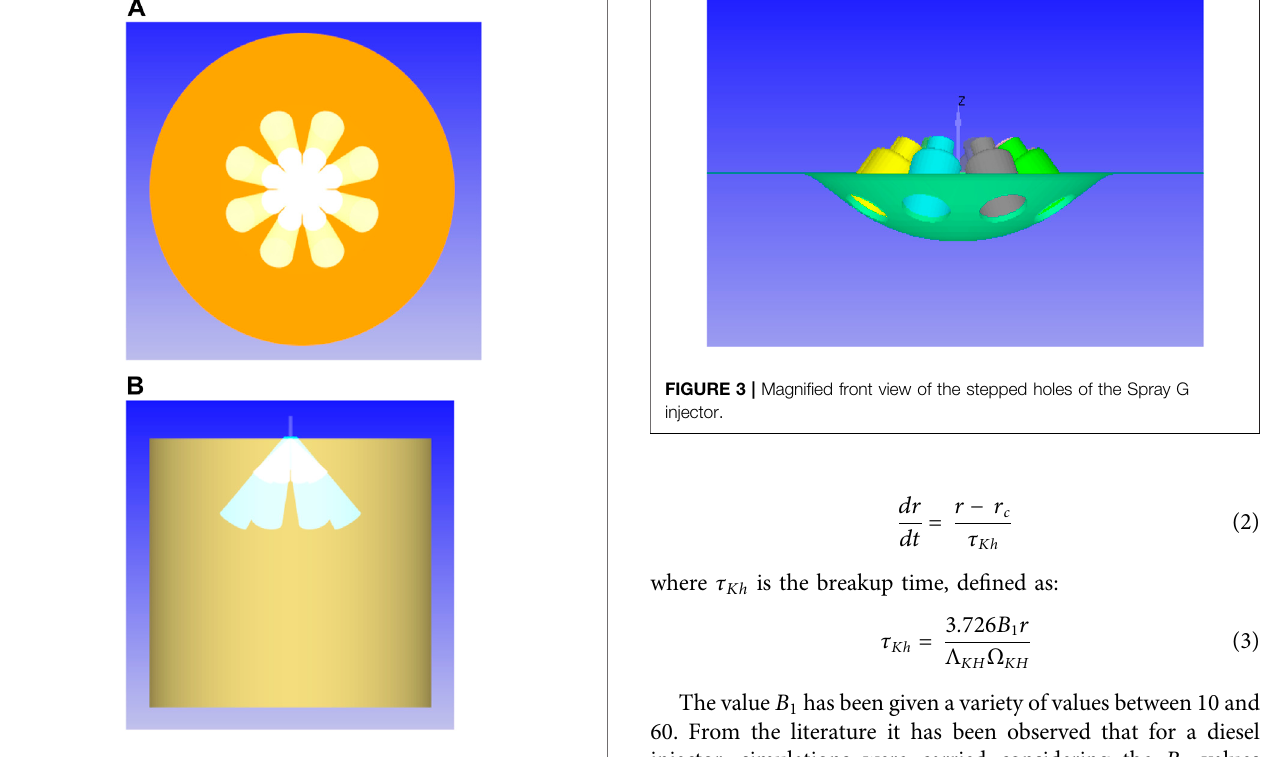
FIGURE 2 | Computational domain (A) top view and (B) side